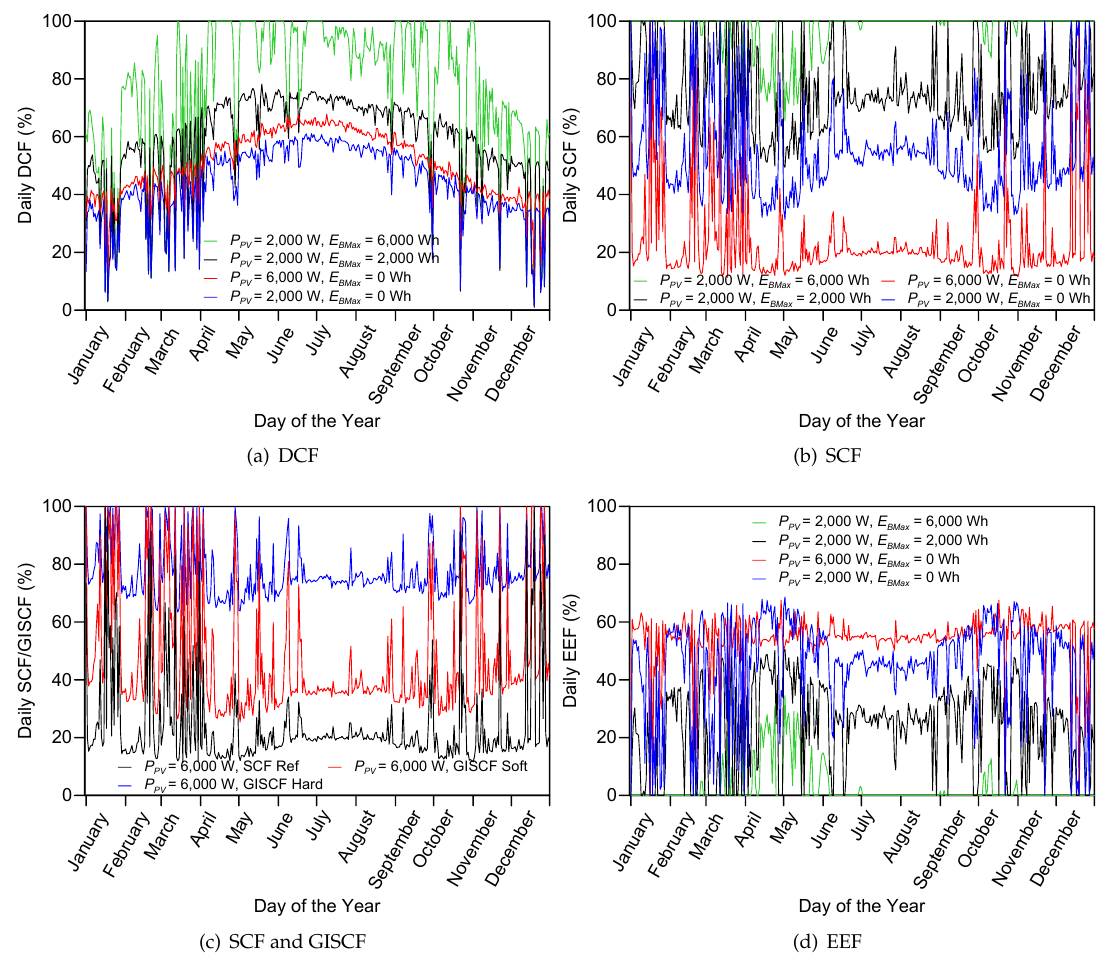
Figure 9. Daily evaluation indexes for 200 households with different installed PV power and storage capacity per